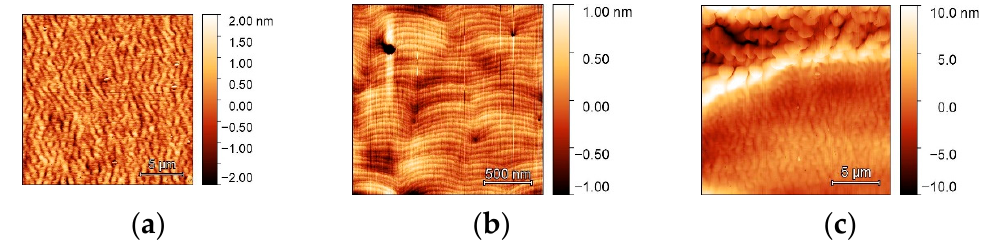
Figure 2. Atomic force microscope (AFM) height images of an InGaN/GaN structure grown on two substrates with stripes. In ( a , b ), stripe direction was parallel to substrate miscut azimuth and in ( c ) it was perpendicular.